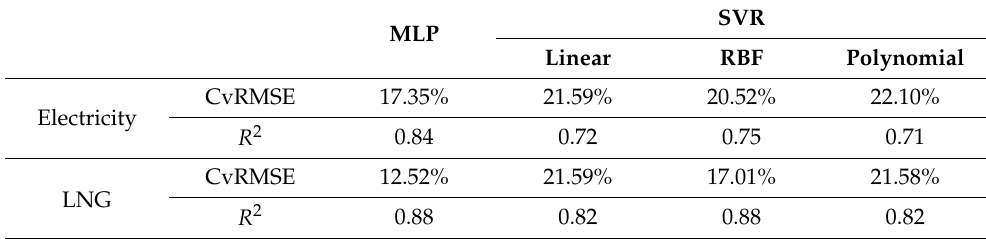
Table 8. Evaluation of the prediction results for the MLP and SVR (linear, RBF, and polynomial).